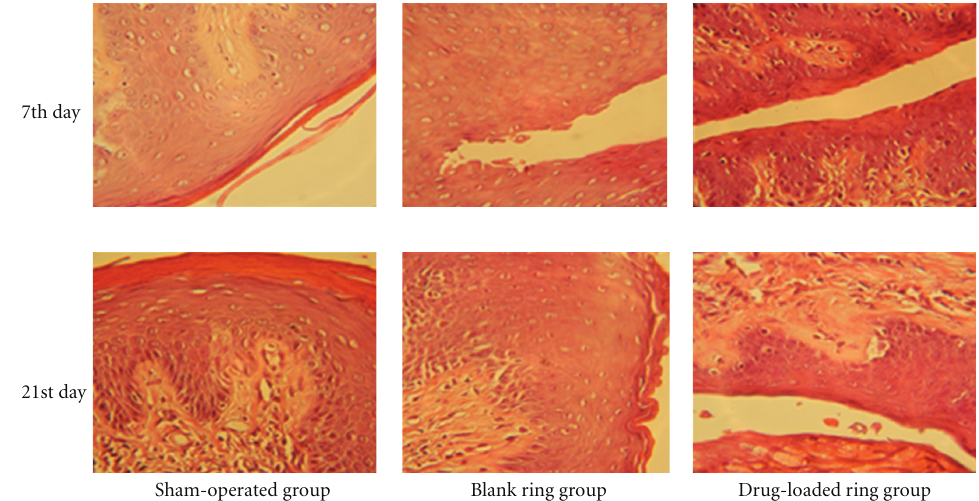
Sham-operated group Blank ring group Drug-loaded ring group F 11: Morphology of vaginal tissues aer application of VCR containing DRSP. Drospirenone IVR cut into rod about 1cm length was administered into the vagina of the rats. e vaginal tissues of three different experimental groups ( n = 10 each) were used aer 7th